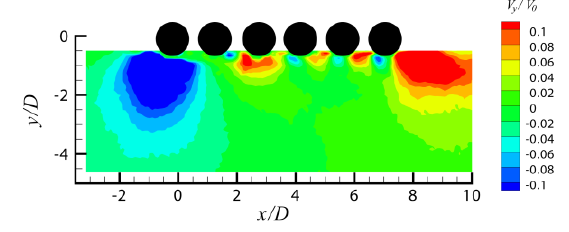
Fig. 4. Normalized mean transverse velocity component contour plot for obtained lateral region